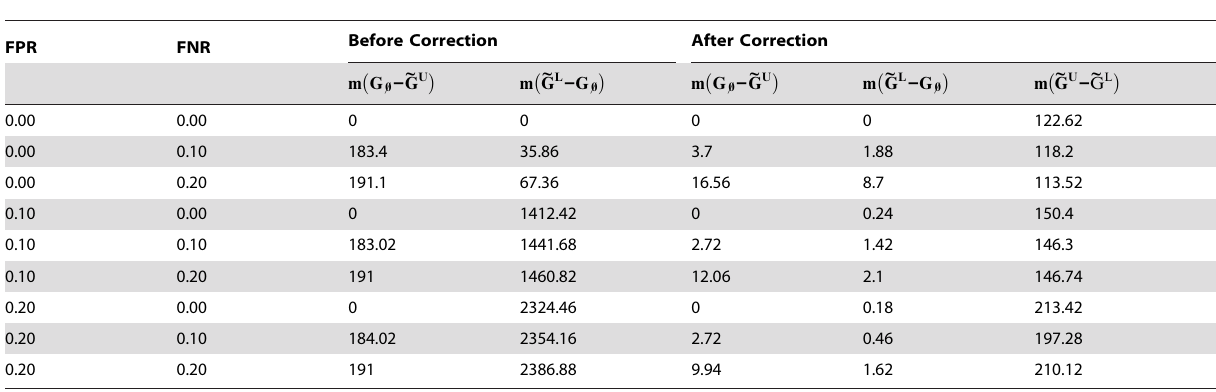
Table 2. Ensemble inference of E. coli subnetworks ( n ~ 100 genes).